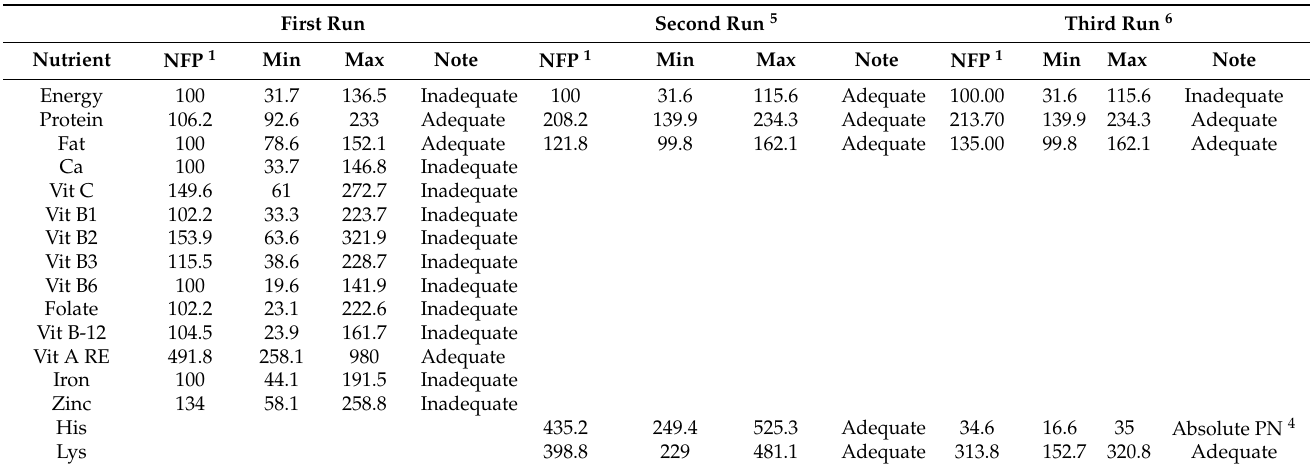
Table 3. LP Output of stunted non-wasted